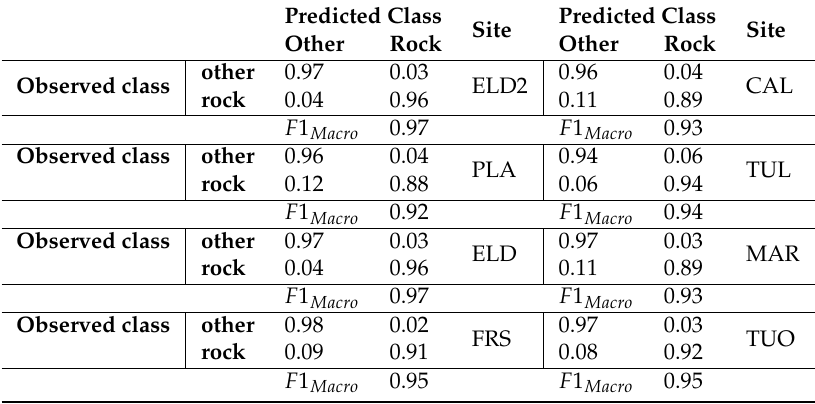
Table 5. Confusion Matrix and F 1 Macro for Each Test